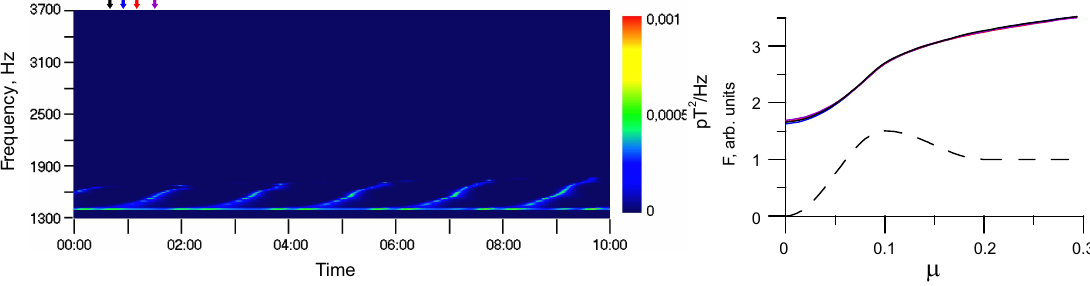
Fig. 8. The same as in Figs. 6 and 7 but for even wider peak on the source pitch angle distribution: æ 1 = 0 . 2. Permanent generation in the low-frequency band is accompanied with periodic spike generation at higher frequencies.